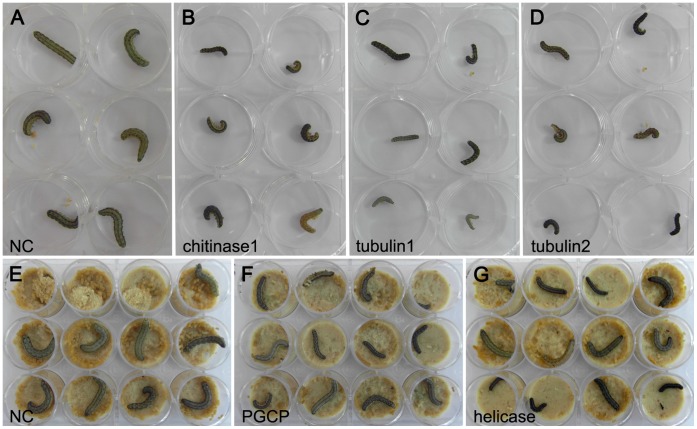
Retarded development in RNAi-treated groups.About 80% of surviving larvae in each siRNA-treated group showed retarded development. The group injected with siRNA with a random sequence was used as the negative control (NC). All photos were taken 48 h after injecting siRNAs. All the treatments are in same condition. To take good photos, we moved the insects to the lid of Petri dishes. However, in some cases, we took the picture directly with diet as the background.